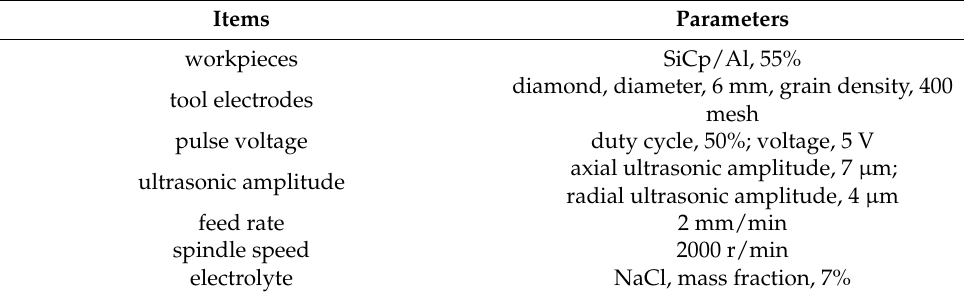
Table 1. Same machining parameters under different control methods.